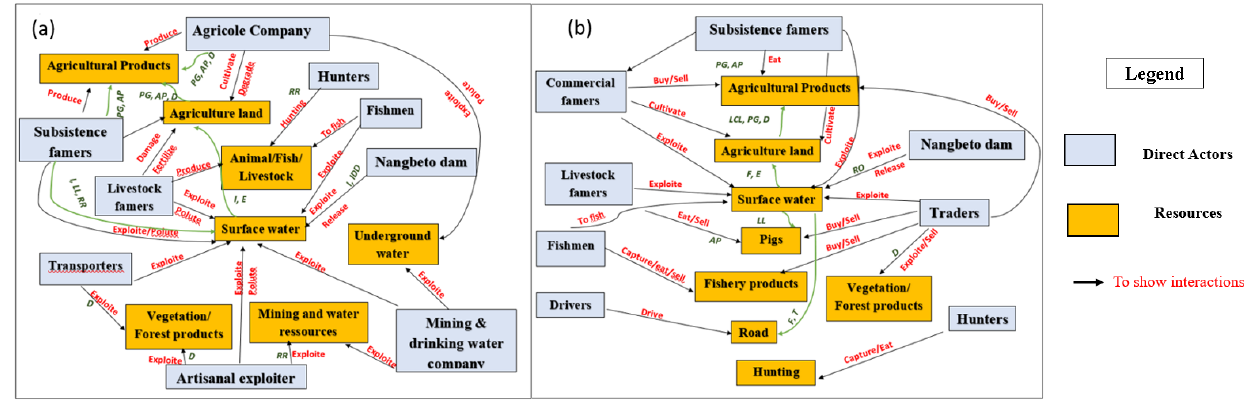
Figure 4. Diagram of interactions according to ( a ) Local communities; ( b ) Experts (Note: AP = Agri- cultural growth, D = Deforestation, E = Erosion, F = Flood, IDD = Installation of dam and dikes, LCL = Loss of cultivated land, LL = Loss of livelihood, PG = Population growth, RR = Resource reduction.)